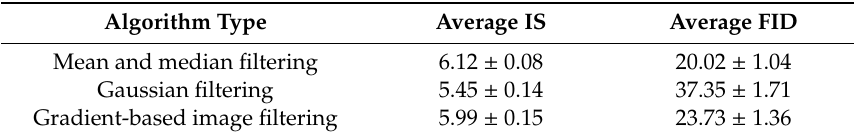
Table A7. We compared the IS and FID of di ff erent edge-smoothing algorithms: mean and median filtering, Gaussian filtering, and gradient-based image filtering. We gathered statistics for 10 training exercises, and the di ff erence was statistically significant ( p < 0.05).